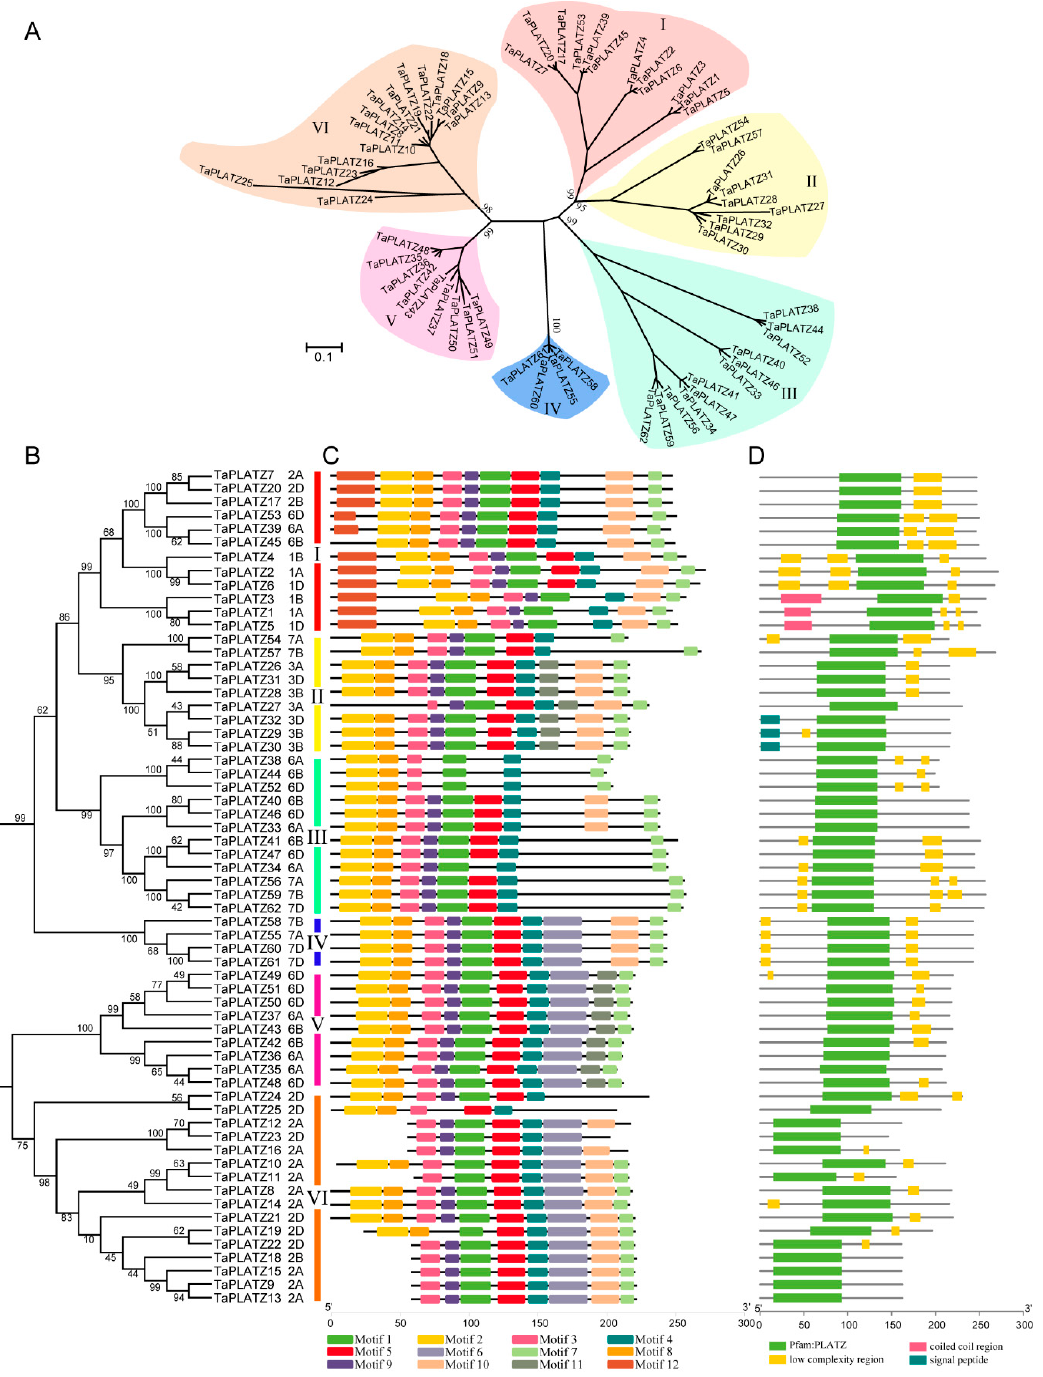
Figure 1. Phylogenetic relationship, motif structure, and conservation analysis of TaPLATZ genes. ( A ) An unrooted phylogenetic tree of TaPLATZ genes. Percent of bootstrap values are given for the main branches and support the classification in subfamilies; ( B ) The neighbor-joining tree of TaPLATZ proteins. I-VI: TaPLATZs were divided into six groups and are represented using different colors; ( C ) MEME motif structure shows the distinct divergence between groups; ( D ) Batch-smart analysis of PLATZ domain distribution of TaPLATZ proteins.